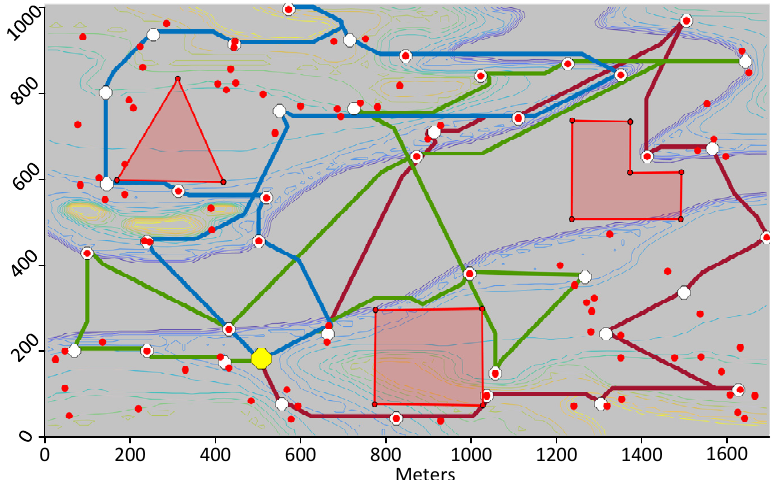
Figure 14. Paths minimizing distance for three UAVs visiting 40 download points covering 100 sen- sors.